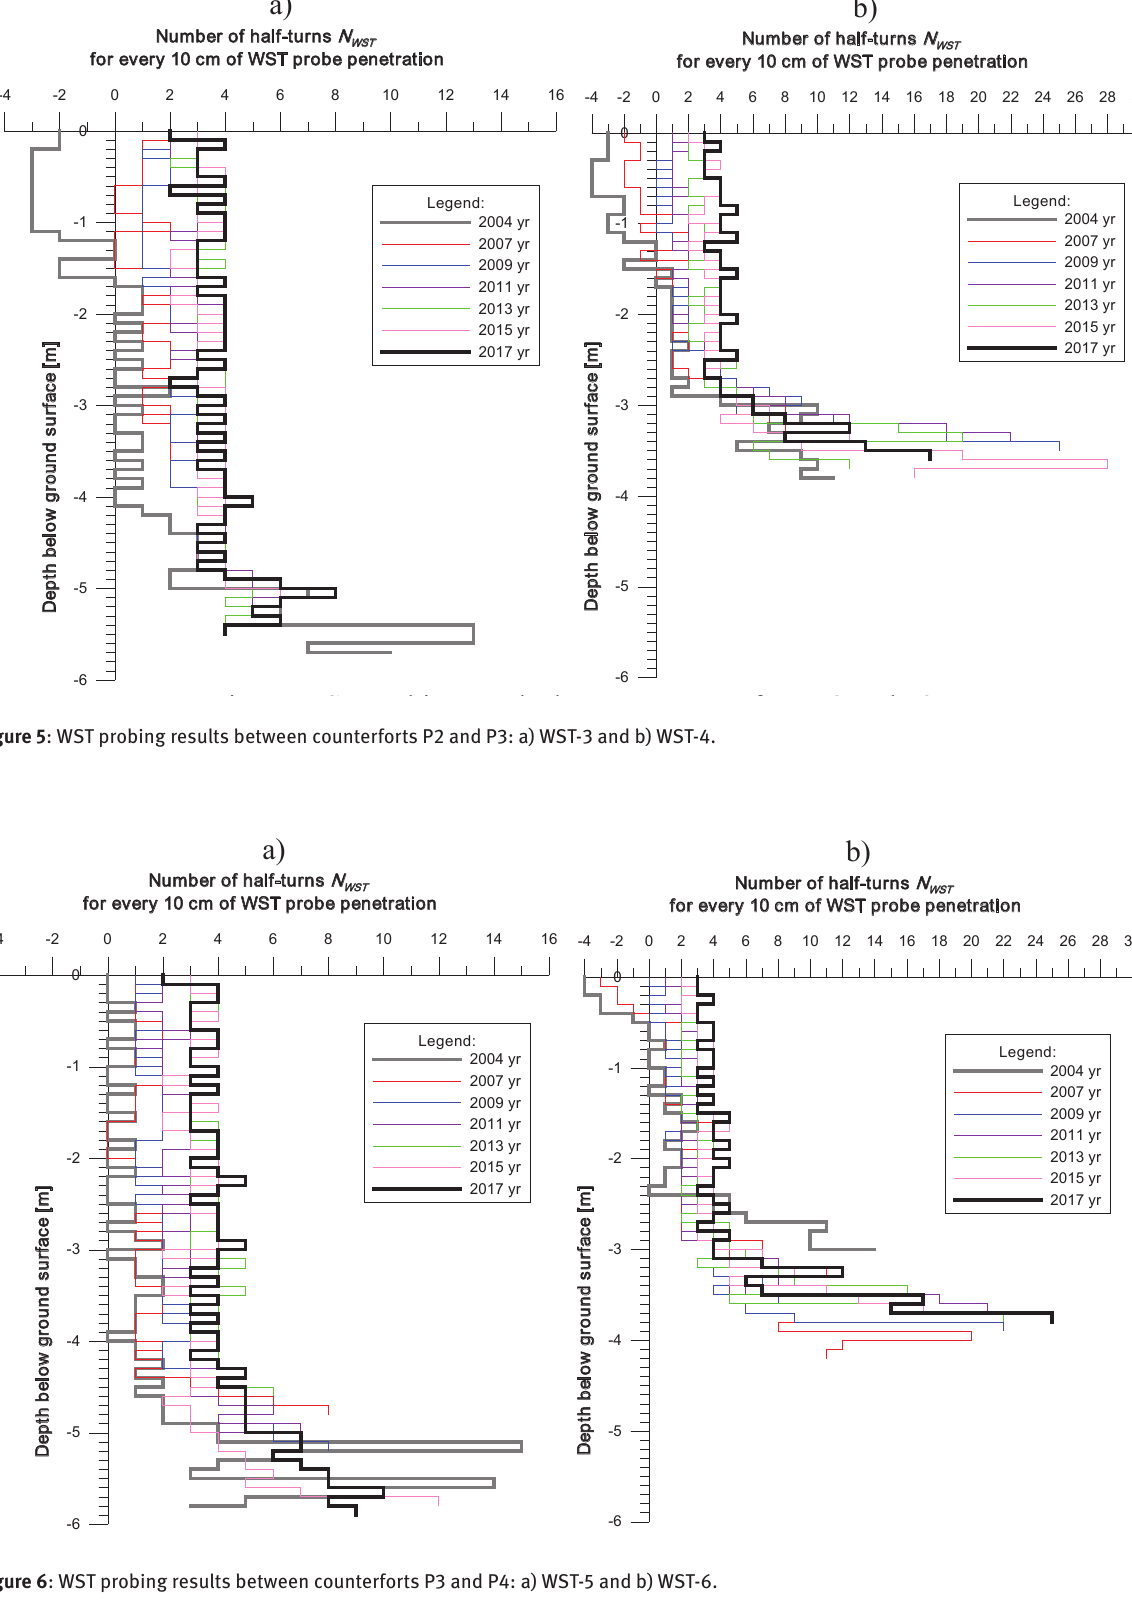
Fig. 4. WST probing results between counterforts P1 and P2